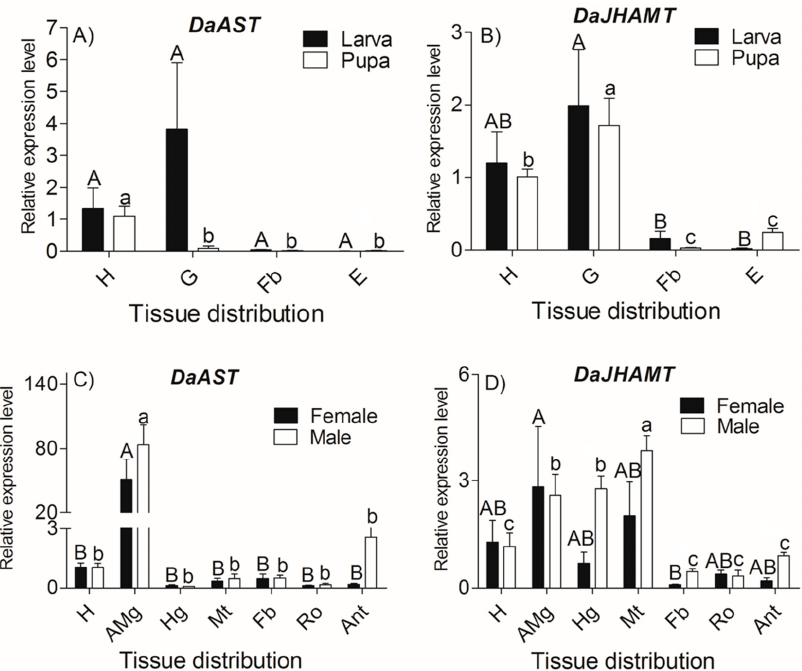
Figure 4. Relative expression of DaAST and DaJHAMT genes (mean ± SE) in different tissues of larvae, pupae and emergent adults. ( A ) DaAST of larvae and pupae; ( B ) DaJHAMT of larvae and pupae; ( C ) DaAST of emergent adults and ( D ) DaJHAMT of emergent adults. The tissues included the head (H), anterior midgut (AMg), hindgut (Hg), Malpighian tubule (Mt), fat body (Fb), reproductive organ (Ro: testes of males and ovaries of females), antennae (Ant), gut (G) and epidermis (E) of D. armandi . The results represent the means ± SE of three independent experiments. In both graphs, transcript levels are represented as relative expression to the head (H) of males and females. All templates were normalized with CYP4G55 and β -actin . The 2 −ΔΔ Ct and SE values were used for plotting. Uppercase letters mark significant differences in females or larvae, while lowercase letters mark males or pupae (one-way ANOVA, p < 0.05, with Tukey’s test of multiple com- parisons).